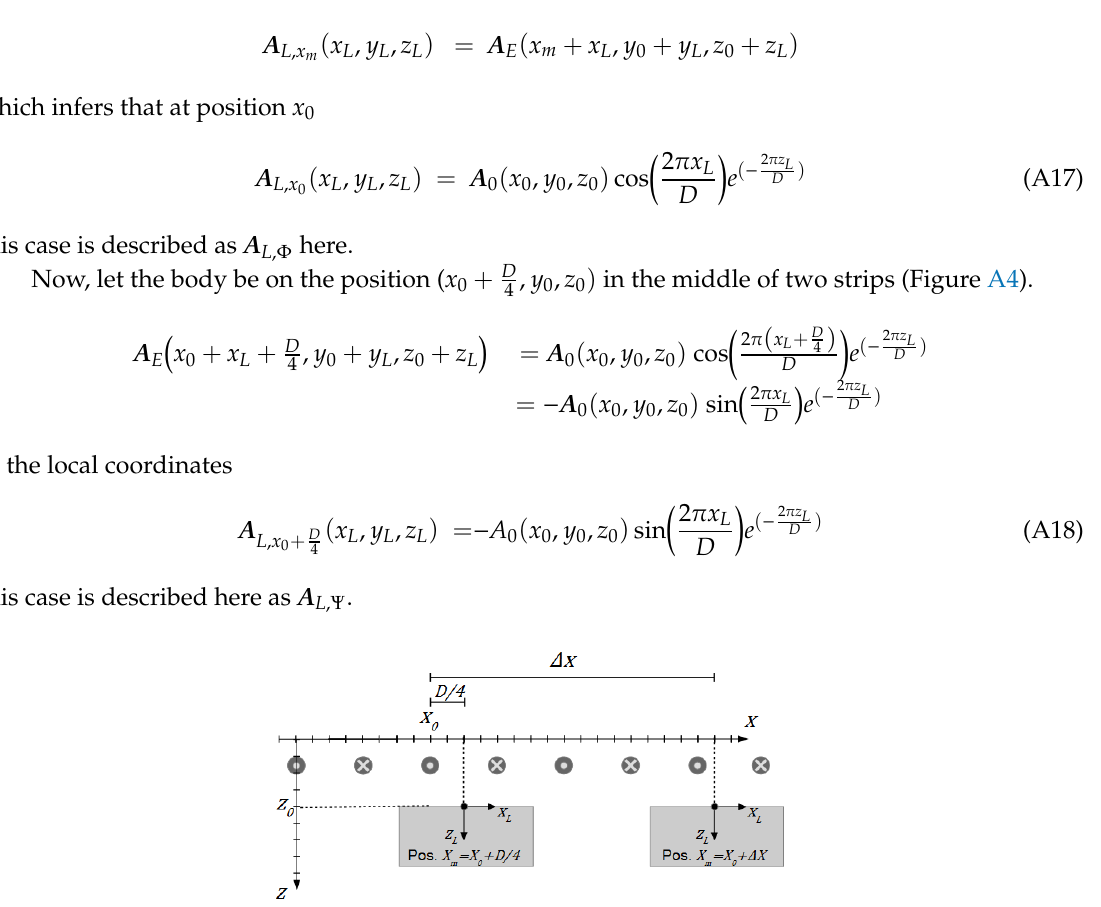
Figure A4. Body at position x 0 + D /4 in front of the Figure A4 . Body at position 𝑥 0 + 𝐷/4 in front of the undulator